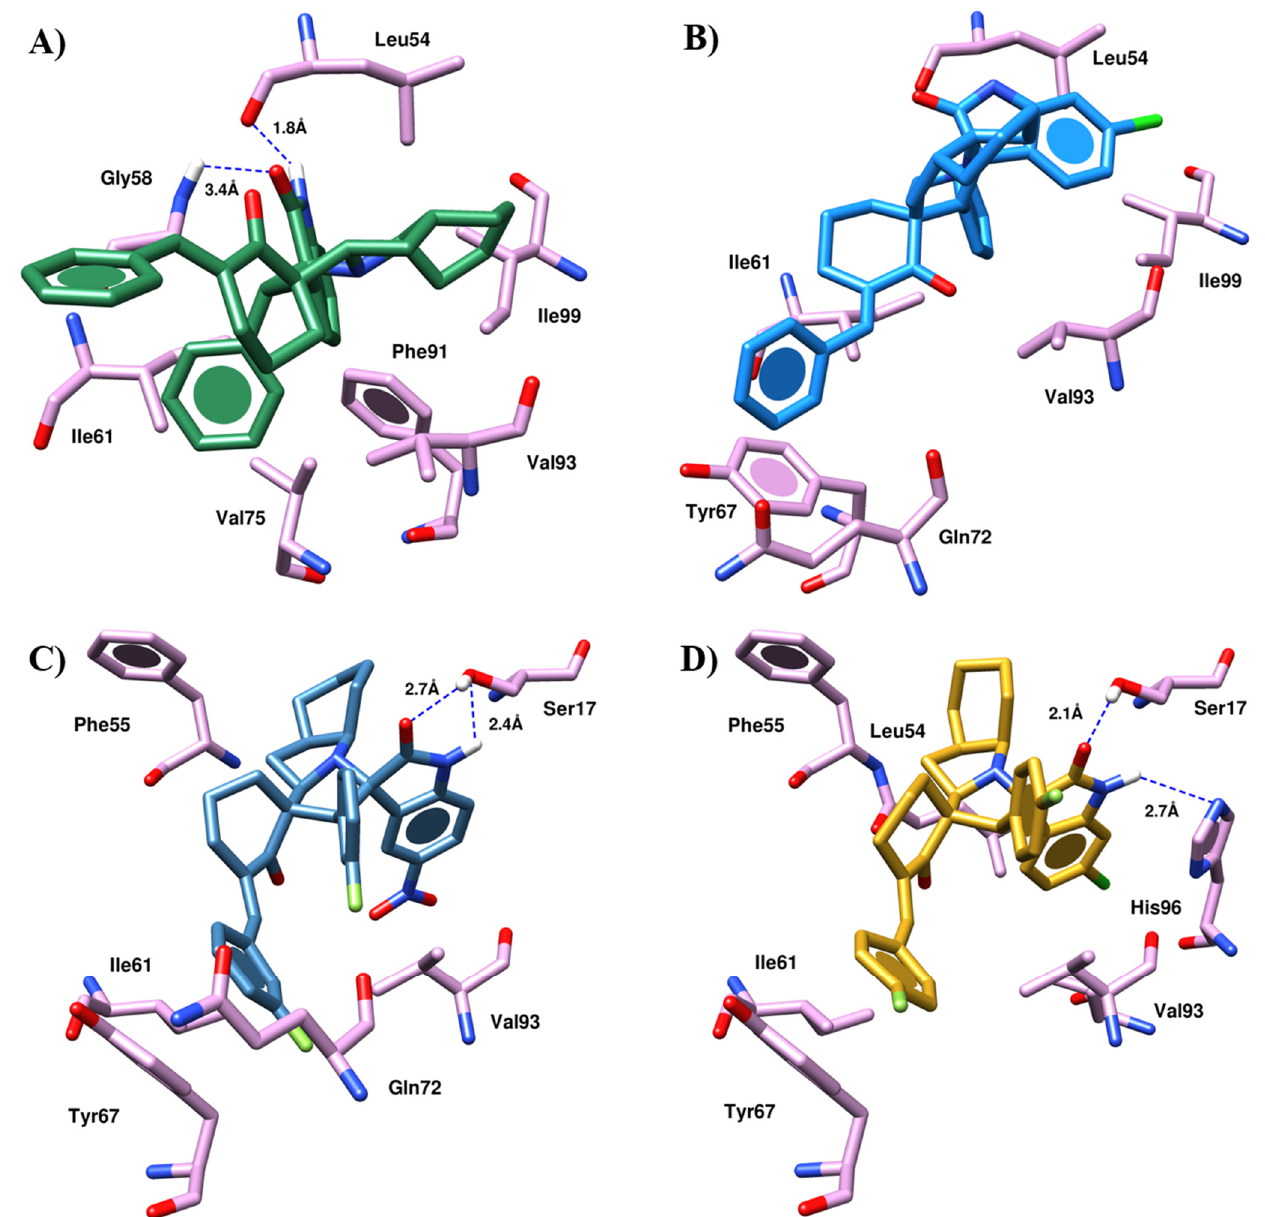
Figure 3. Docked pose of compounds ( A ) 4a , ( B ) 4b , ( C ) 4i , and ( D ) 4l in the binding site of MDM2. Compound 4a showed a slightly different binding mode in comparison to 4b , 4i , and 4l . The unsubstituted oxindole ring of 4a interacts with the side chain of Leu54 and Gly58 while the substituted oxindole ring of 4b , 4i , and 4l is buried deeply in the binding cavity of MDM2 by interacting with Val93, His96, and Ile99. Substitution on the oxindole ring may account for the different binding mode of the di-spirooxindole analogs within the binding cavity of MDM2. Similarly, compound 4a confers two hydrogen bond contacts with the carboxyl group of Leu54 and Gly58. Six-membered aromatic rings in the 4a mediate π - π and π -alkyl interactions with the binding site residues of MDM2, including Leu54, Ile61, Val75, Phe91, Val93, and Ile99, which projected 4a firmly in the binding pocket. The compound 4b resides comfortably in the binding site extending hydrophobic interactions with Leu54, Ile61, Tyr67, Gln72, Val93, and Ile99, while no hydrogen bond was observed. The docked pose of compound 4i suggested a number of significant hydrophobic interactions with binding site residues. Fluorinated phenyl rings stacked between Ile61, Tyr67, and Val93 produced hydrophobic effects. Similarly, Phe55 was also